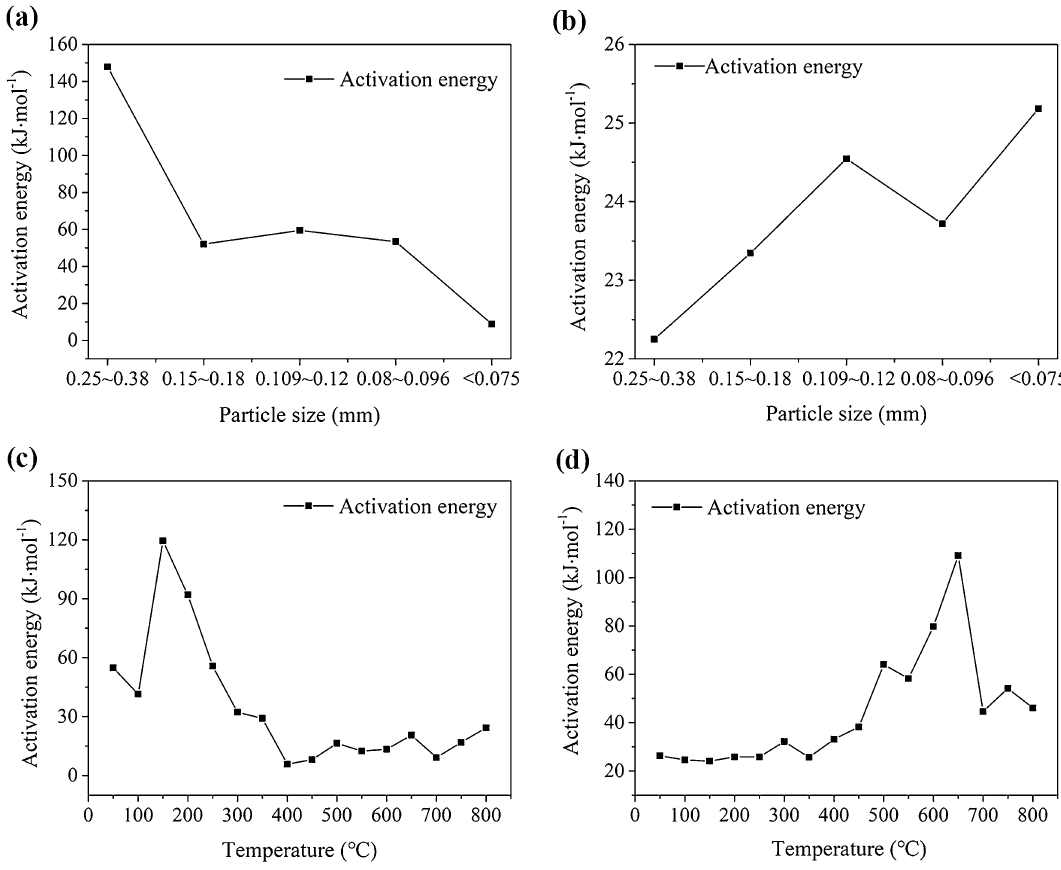
Figure 8. Results from TG experiments ( a , b the activation energy with different particle sizes in stages T 1 –T 2 and T 3 –T 5 respectively; c , d the activation energy of heated samples in stages T 1 –T 2 and T 3 –T 5